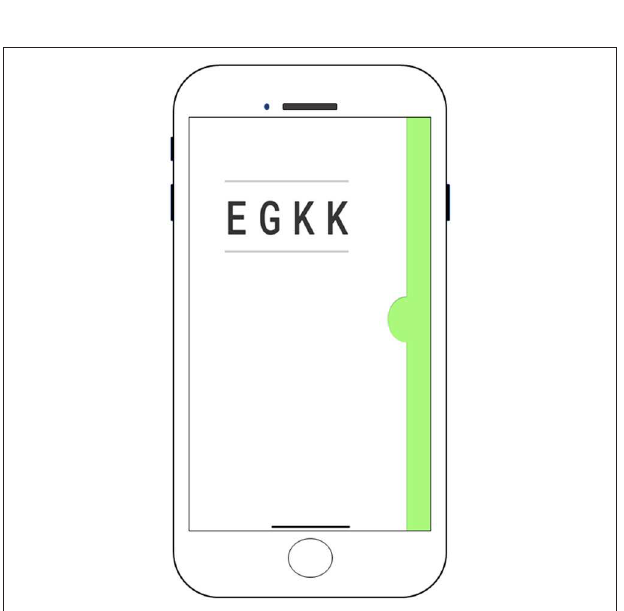
FIGURE 4 | “I do remember” screen of Location Indicators. FIGURE 5 | “I don’t remember” screen of Location